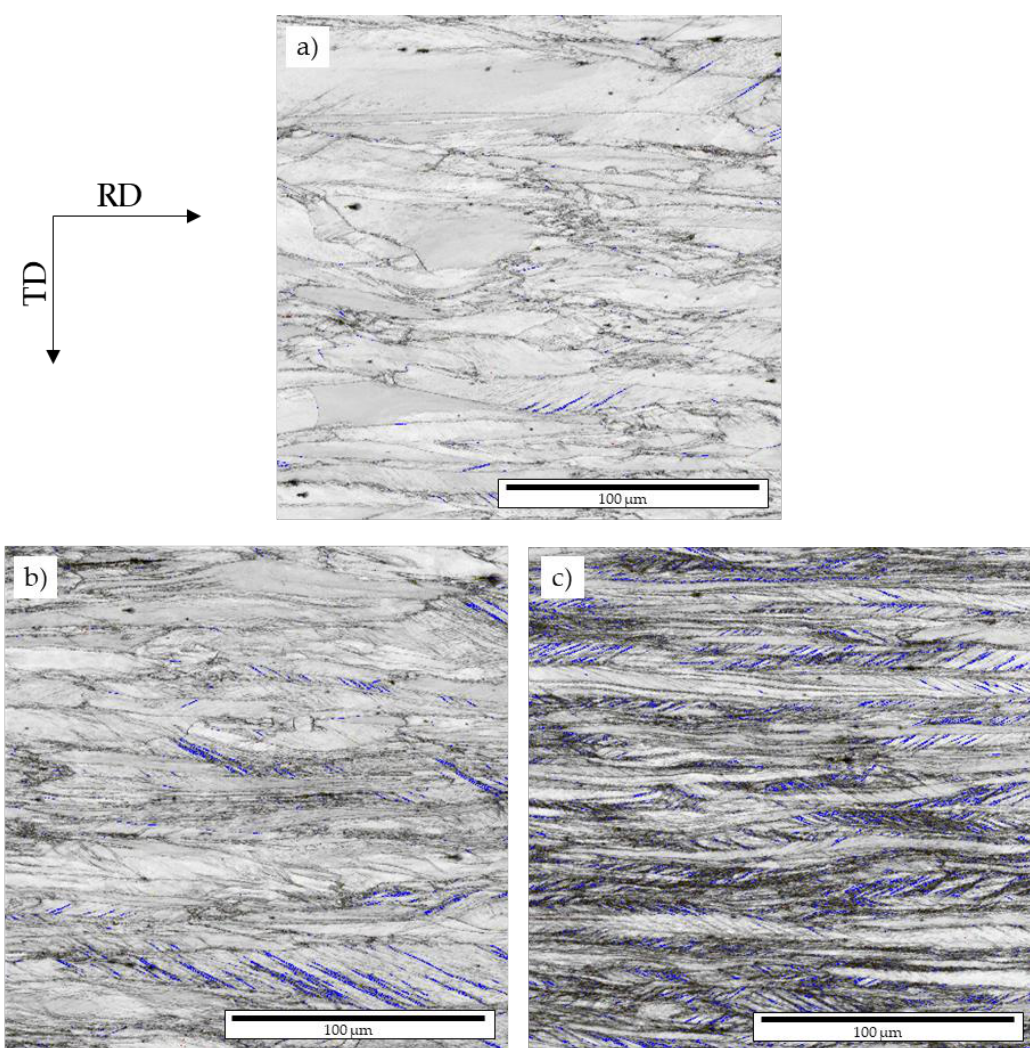
Figure 3. EBSD-IQ maps of the investigated steel warm-rolled at 500 °C to thickness reductions of ( a ) 50%, ( b ) 60%, and ( c ) 70%. Blue lines indicate deformation twin boundaries (60° <111>).